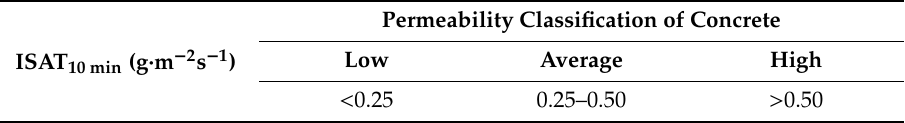
Table 4. Indicative assessment of concrete permeability using ISAT